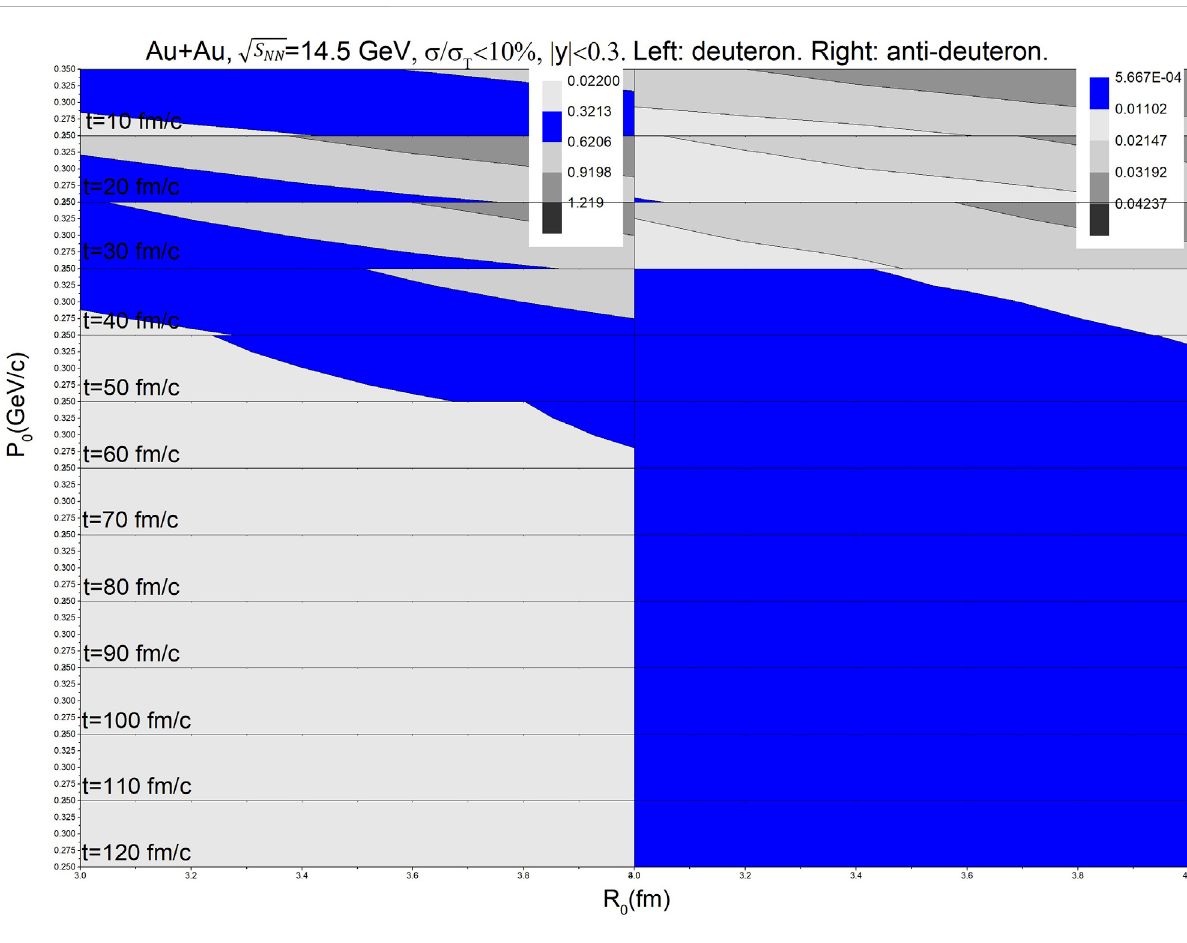
Time evolution of R 0 - P 0 contour plots of (anti-)deuteron from the central Au + Au collisions at range of experimental data from the STAR collaboration